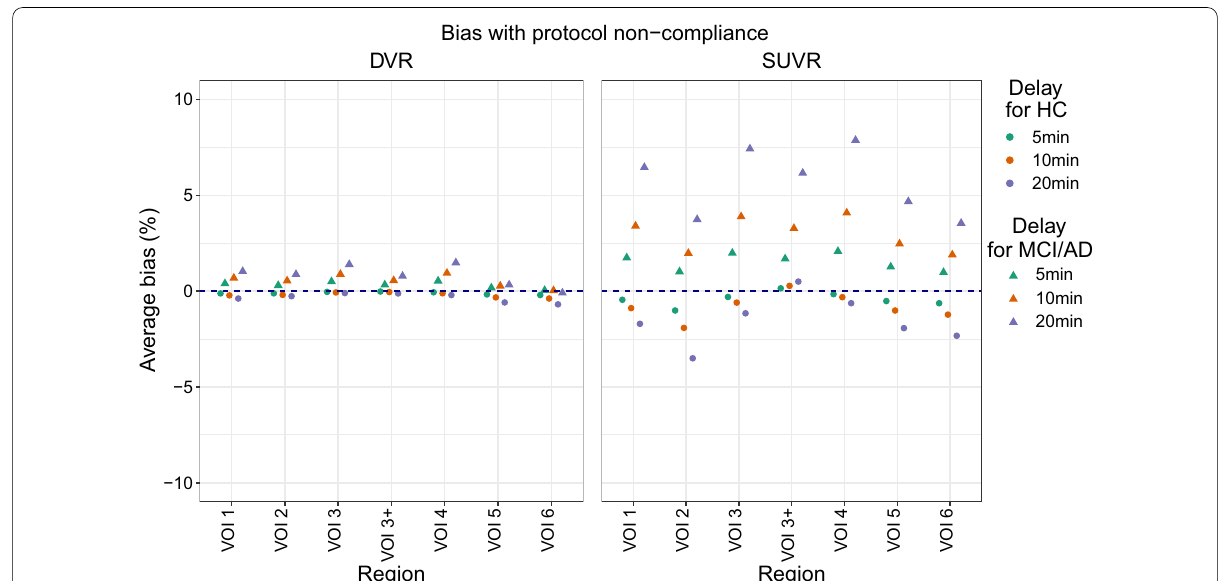
Fig. 3 Ref Logan DVR bias (left) and SUVR 90 bias (right) due to scan protocol non-compliance resulting in delays on the start of the late time point scan (i.e., Part 2 of the DTW protocol). Average bias was calculated for subjects with the same diagnosis, indicated by symbol shape. Delay length is indicated by